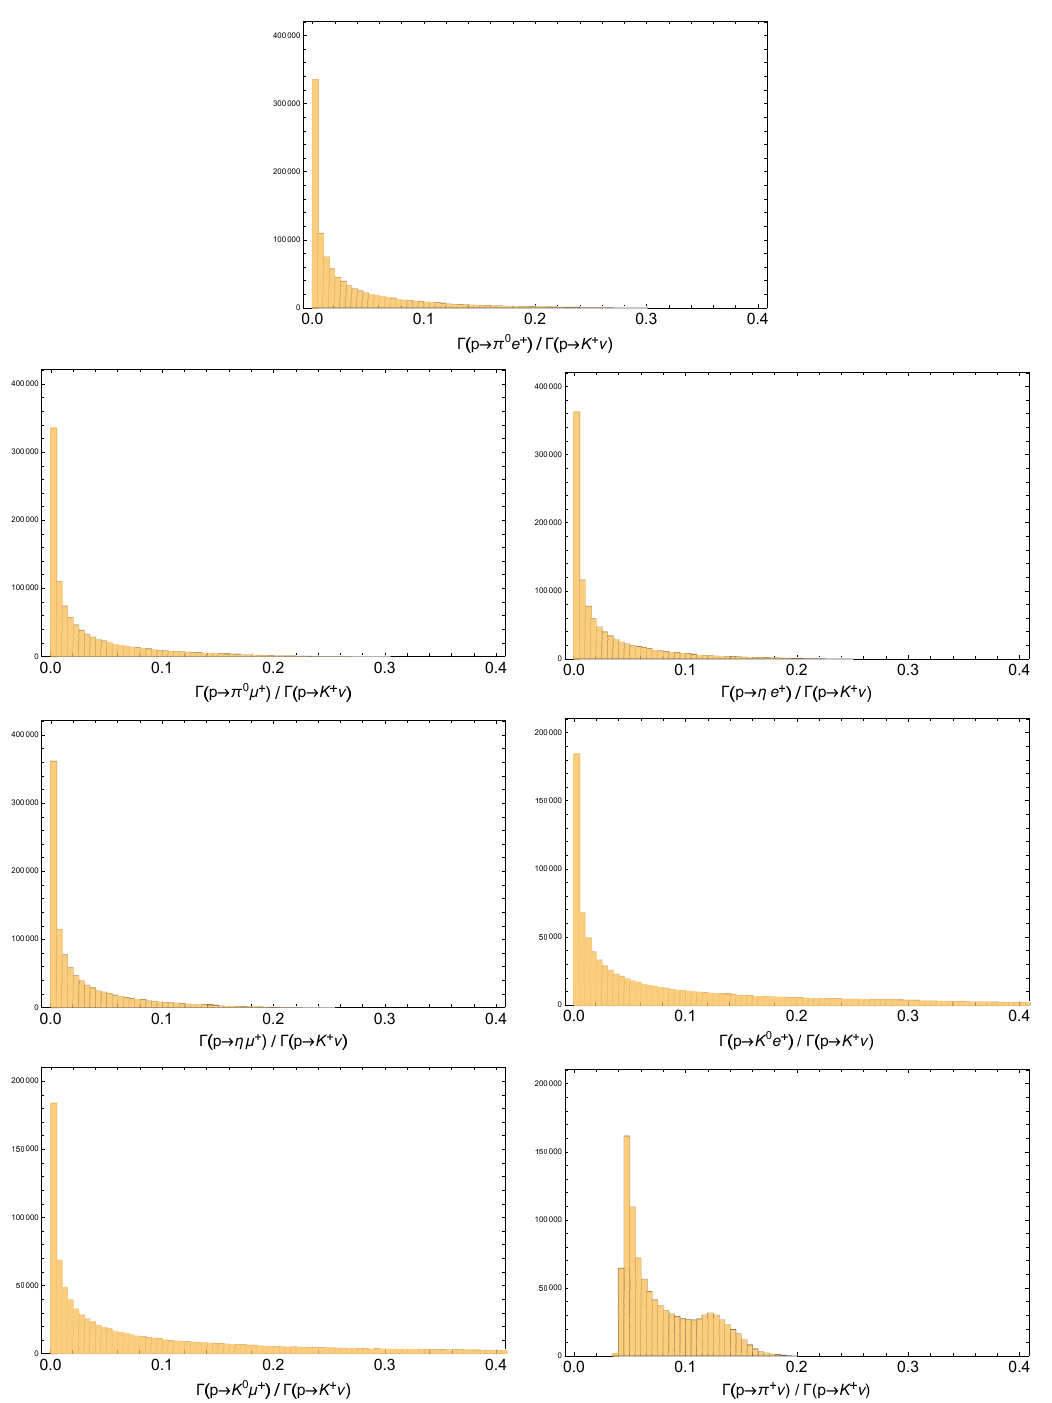
Figure 1 . Distributions of proton decay partial width ratios corresponding to randomly varied values of the unknown unitary matrix U , unknown phases φ 1 , φ 2 , φ 3 , and relative phase between M and µ h . The vertical axis is linear and in arbitrary units. Here we assume tan β = 5 e W